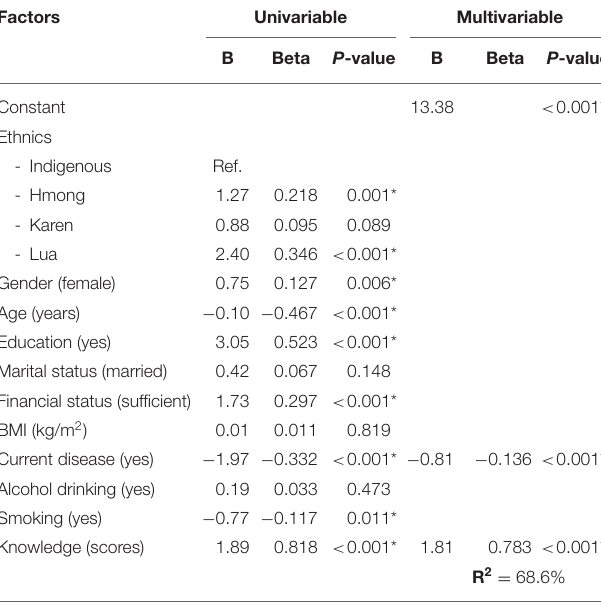
TABLE 4 | Factors associated with HbA1c in agricultural workers by linear regression ( n =